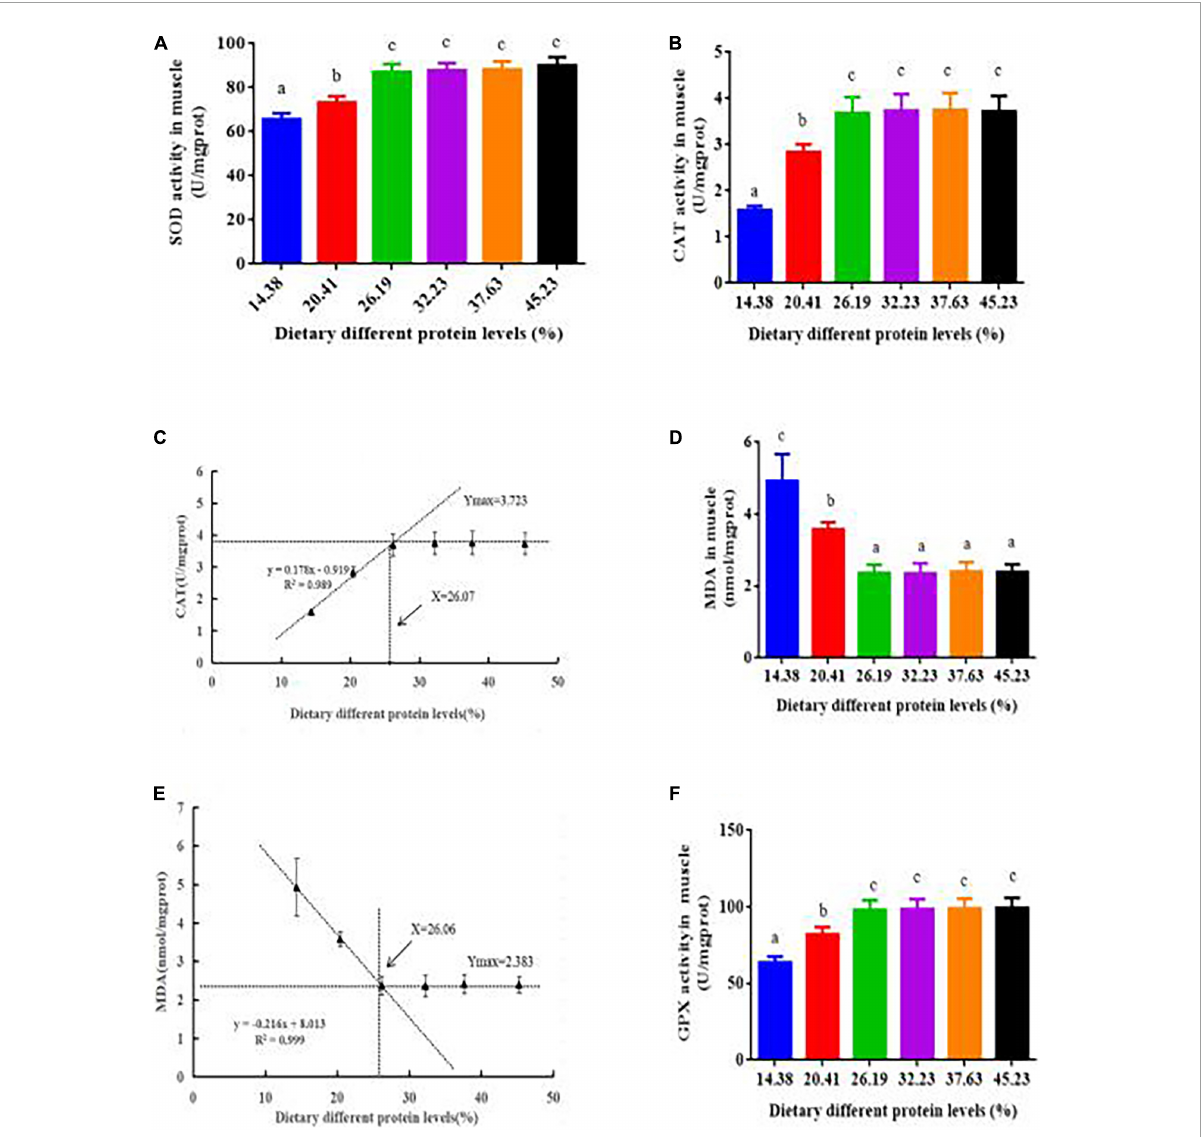
FIGURE5 Antioxidant activity in the muscle of juvenile softshell turtles fed a gradient of dietary supplementary protein levels for 8 weeks. (A) Superoxide dismutase activity (SOD) and (B) catalase activity (CAT). (C) Plot presenting the correlation between catalase activity (CAT) and protein levels according to the fitted broken-line model. The breakpoint is 26.07% protein. (D) Malondialdehyde (MDA). (E) Plot presenting the correlation between malondialdehyde (MDA) and protein levels according to the fitted broken-line model. The breakpoint is 26.06% protein. (F) Glutathione peroxidase activity (GPX). Bars with different letters indicate significant differences among the groups ( P < 0.05). The values shown are the mean ± SD for three